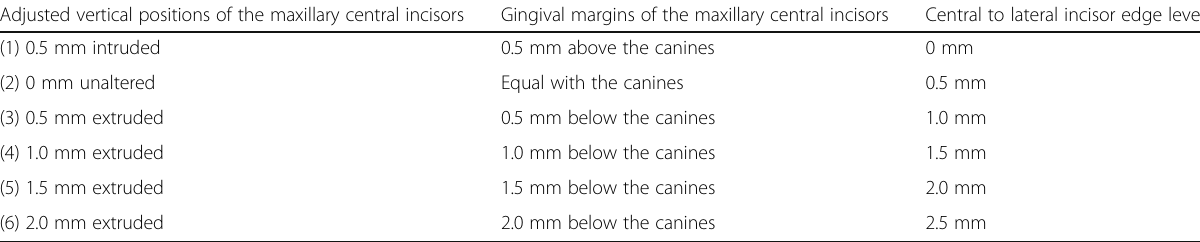
Table 1 Characteristics of the smiles used in this study Adjusted vertical positions of the maxillary central incisors Gingival margins of the maxillary central incisors